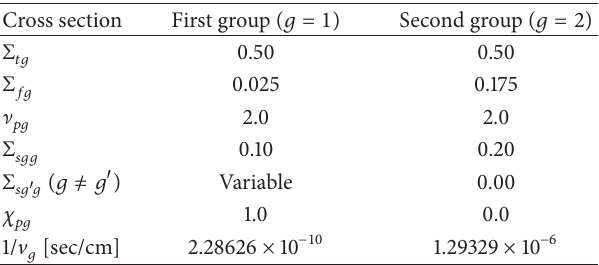
Table 1: Two-group cross sections for the infinite homogeneous problem.